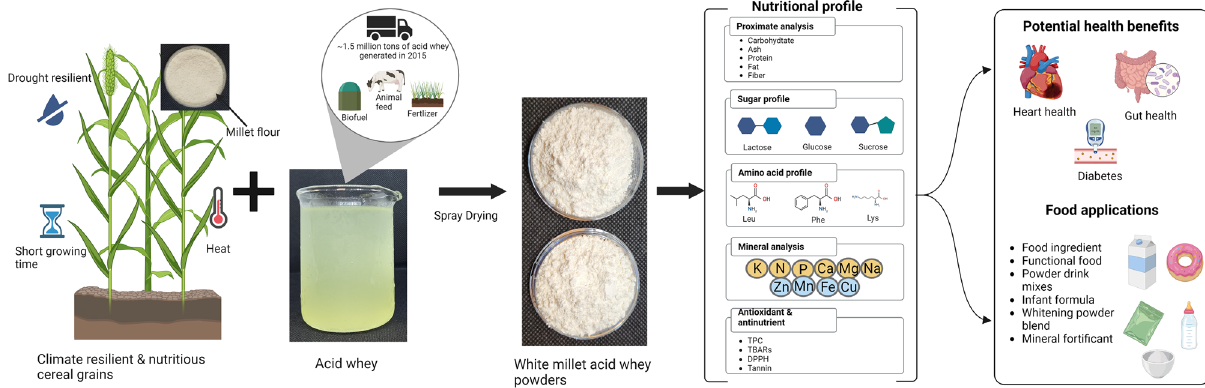
Figure 1. Overall summary of novel white powders and potential industrial applications contributing to sustainable food